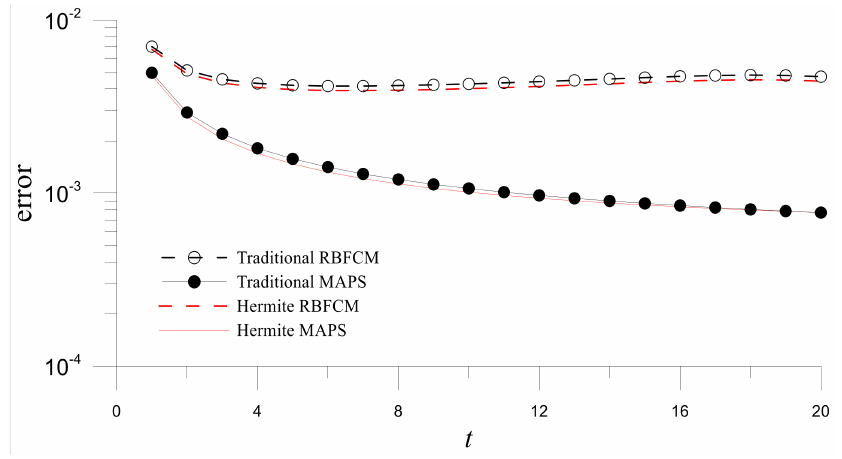
Figure 11. Time histograms of errors for numerical solutions obtained by the four methods in Example 2.